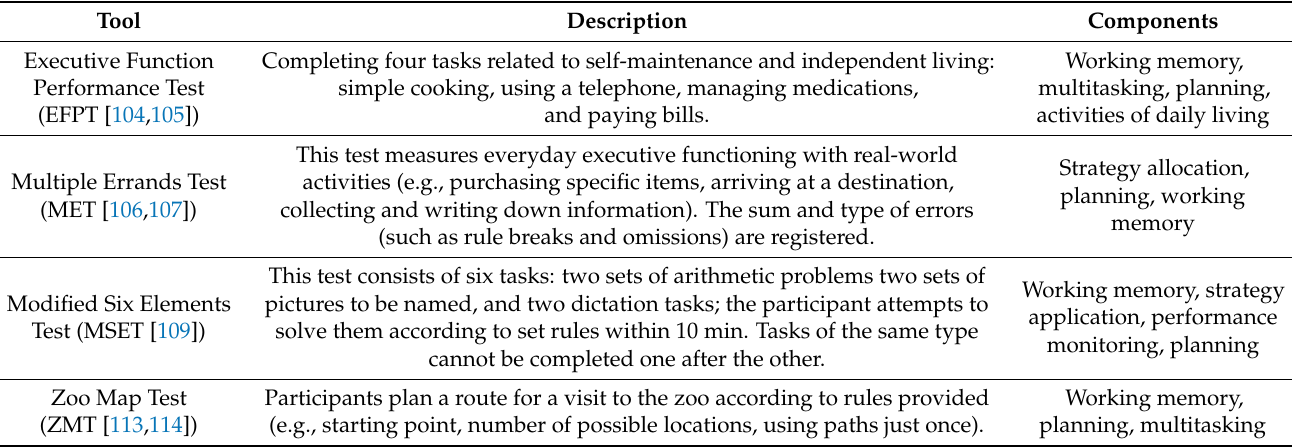
Table 4. Descriptions of the ecological neuropsychological tools used for measuring executive functions in schizophrenia. Tool